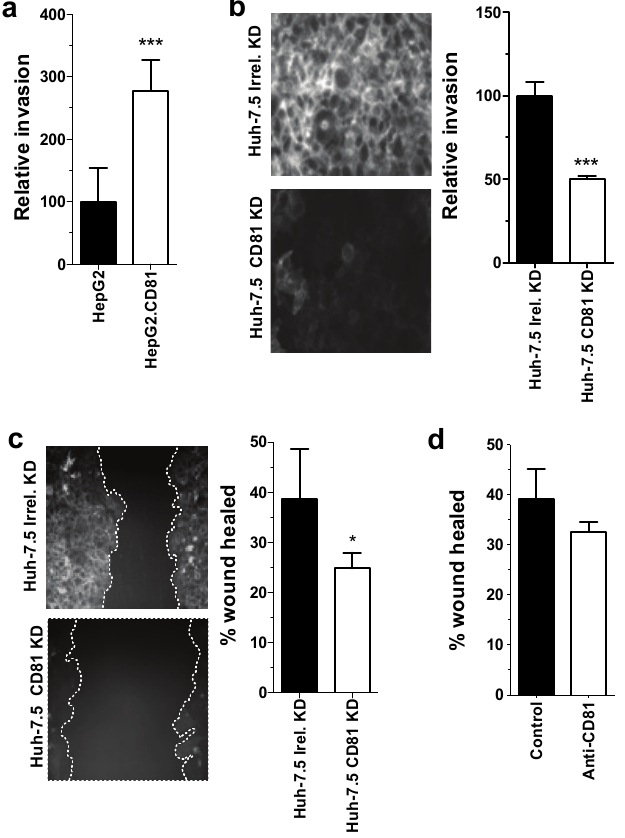
Figure 6. CD81 expression promotes hepatoma cell invasion and migration. Invasion of ( a ) parental or CD81 expressing HepG2; ( b ) naïve and CD81 siRNA transfected Huh-7.5 cells through collagen over 24 h. Immunofluorescence images of CD81 expression in naïve and CD81 siRNA tranfected Huh-7.5 cells ( b ). Phase images and analysis of wound healing in ( c ) naïve and CD81 siRNA tranfected Huh-7.5 cells; ( d ) IgG control or anti-CD81 (1s262, 5 µg/mL) stimulated Huh-7.5 cells. Data presented are from an individual experiment representative of at least three independent experiments, * p ≤ 0.05, *** p ≤